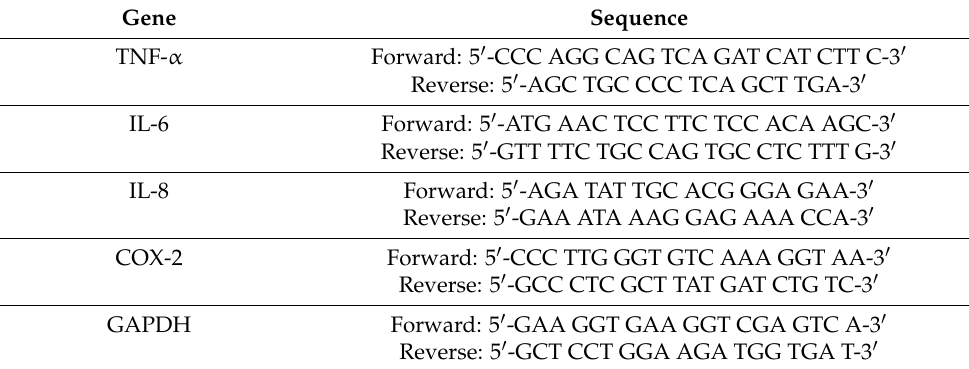
Table 1. List of the primer pairs in the present